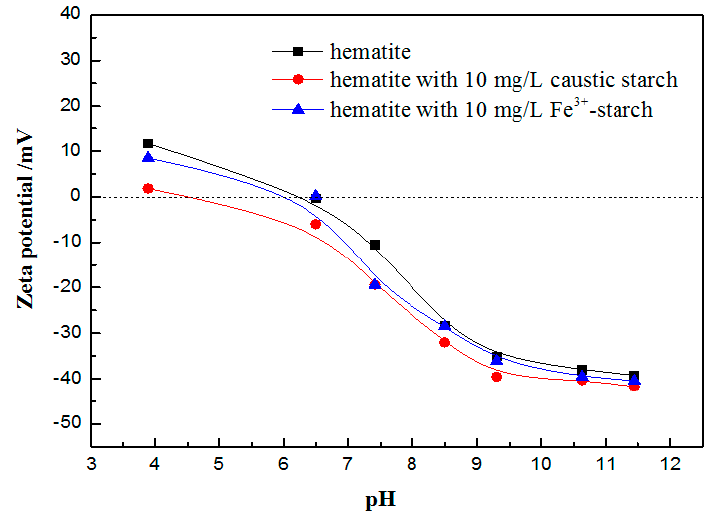
Figure 8. Zeta potential of hematite in the presence of the Fe 3+ -starch as a function of pH.